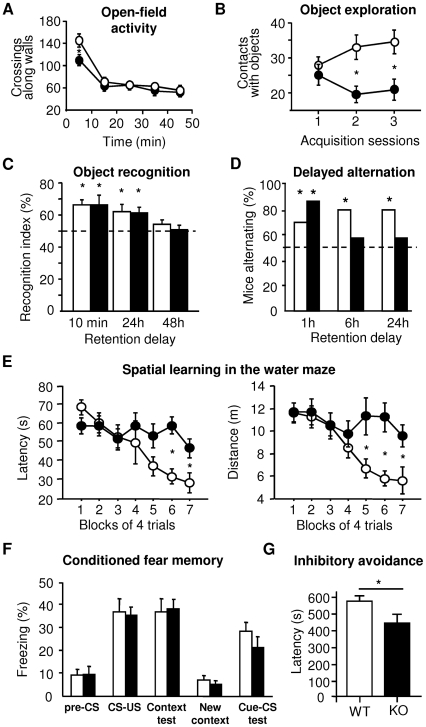
Selective alterations of exploratory behavior and learning and memory performance in Dp71-null mice.KO: Filled symbols; WT: Open symbols. A. Spontaneous locomotor activity during exploration of an empty open-field (9 KO, 10 WT). The number of squares crossed along the walls for 50 min is shown by bins of 5 min recorded every 10 min. *p<0.02. B. Object investigations expressed as the number of contacts made with three different sets of objects used during successive acquisition sessions in the object recognition task (13 KO, 16 WT). *p<0.01. C. Object-recognition memory performance at retention delays of 10 min, 24 h and 48 h. *significantly different from chance (50%), p<0.05. D. Spatial alternation in a T-maze. Data are % of mice alternating (14 KO, 24 WT) at retention delays of 1, 6 and 24 h. *significantly different from 50%, p<0.05. E. Spatial learning in the water-maze (12 KO, 10 WT). Escape latencies (left panel) and distance swum to reach the platform (right panel) monitored over 7 days (1 block of 4 trials per day). *p<0.05. F. Contextual and cued-fear memory. Graph shows percent freezing (12 KO, 13 WT) before (pre-CS) and immediately after administration of the unconditioned stimulus (US, footshock) during learning (CS-US), and during retention trials 24 h later in the same context (context test), or in a new context before (new context) and after presentation of the auditory CS (cue-CS test). G. Inhibitory avoidance learning (17 Dp71-null, 12 WT). Retention performance at 24 h is expressed as the latency to step into the electrified zone. *p<0.05.